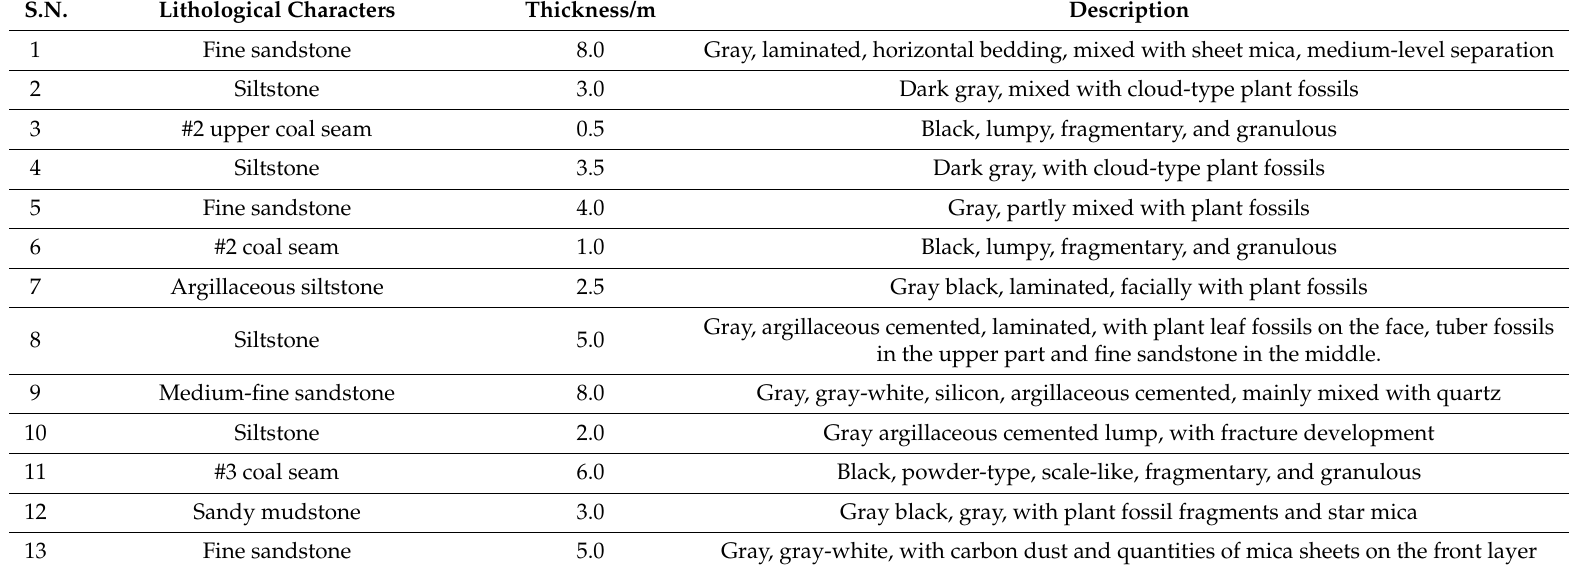
Table 1. The main attitude of the